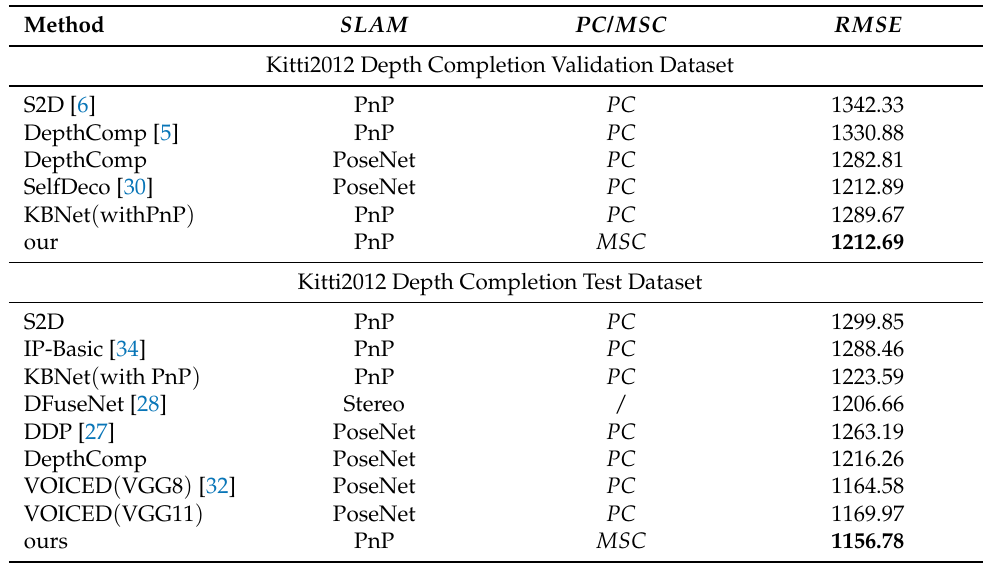
Table 4. The experimental results compared with other methods. The bold numbers are the best.